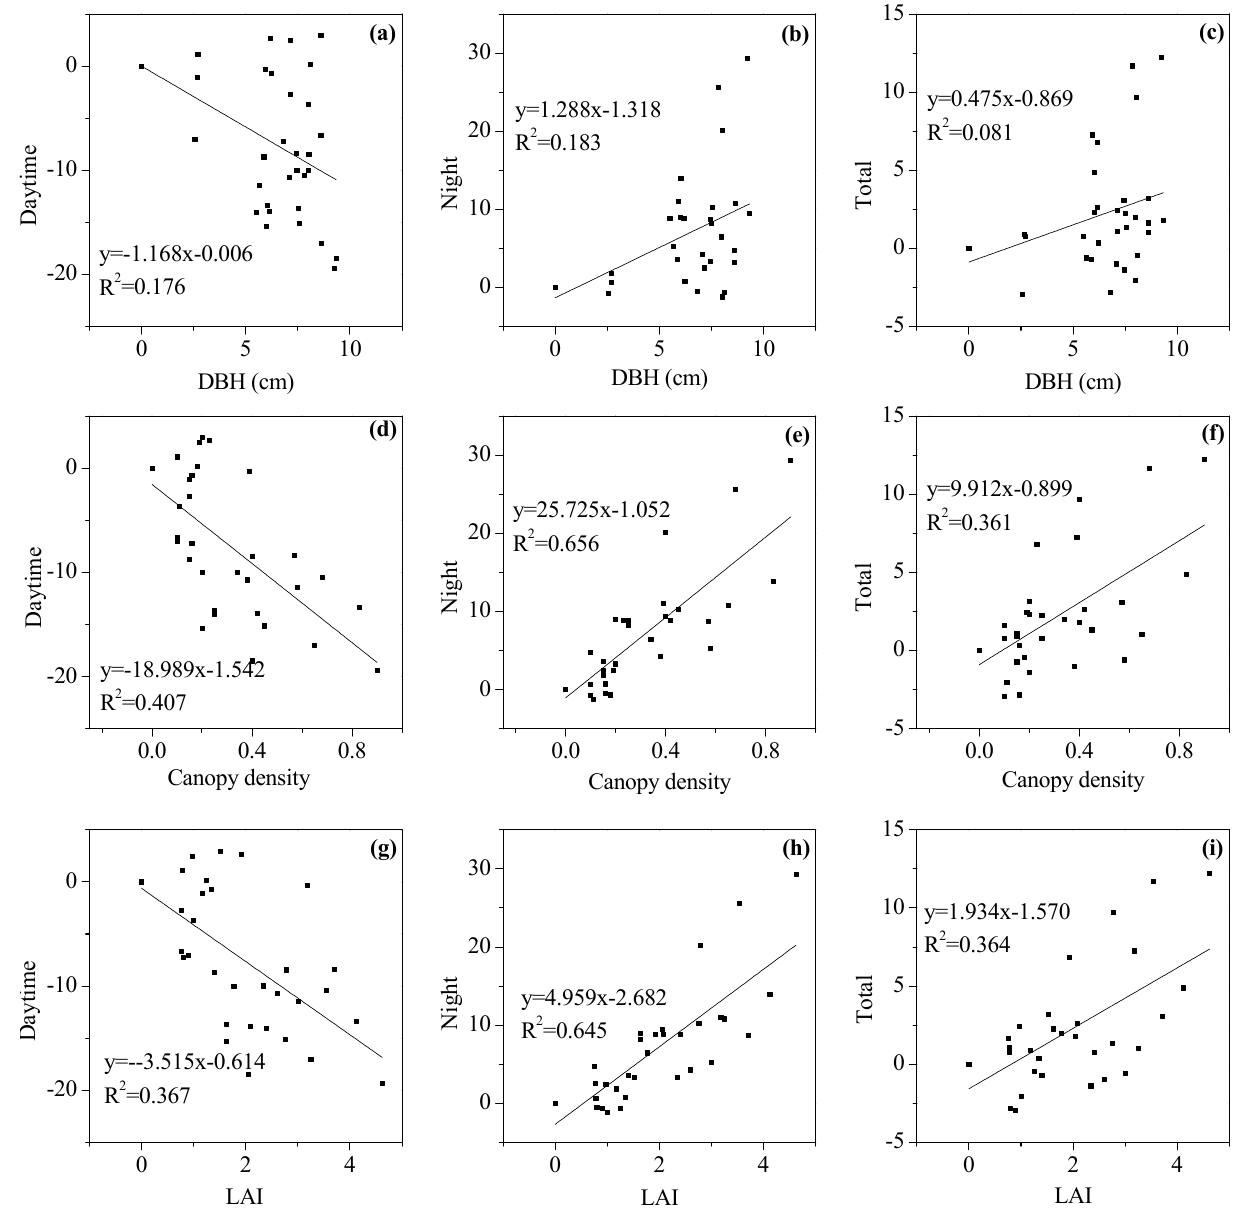
Figure 3. Effects of DBH, canopy density, and LAI on the PM 2.5 concentration index during daytime and night. ( a – c ) The linear relationships between DBH and the PM 2.5 concentration index; ( d – f ) The linear relationships between canopy density and the PM 2.5 concentration index; ( g – i ) The linear relationships between LAI and the PM 2.5 concentration index at daytime, night, and whole day—three diurnal time